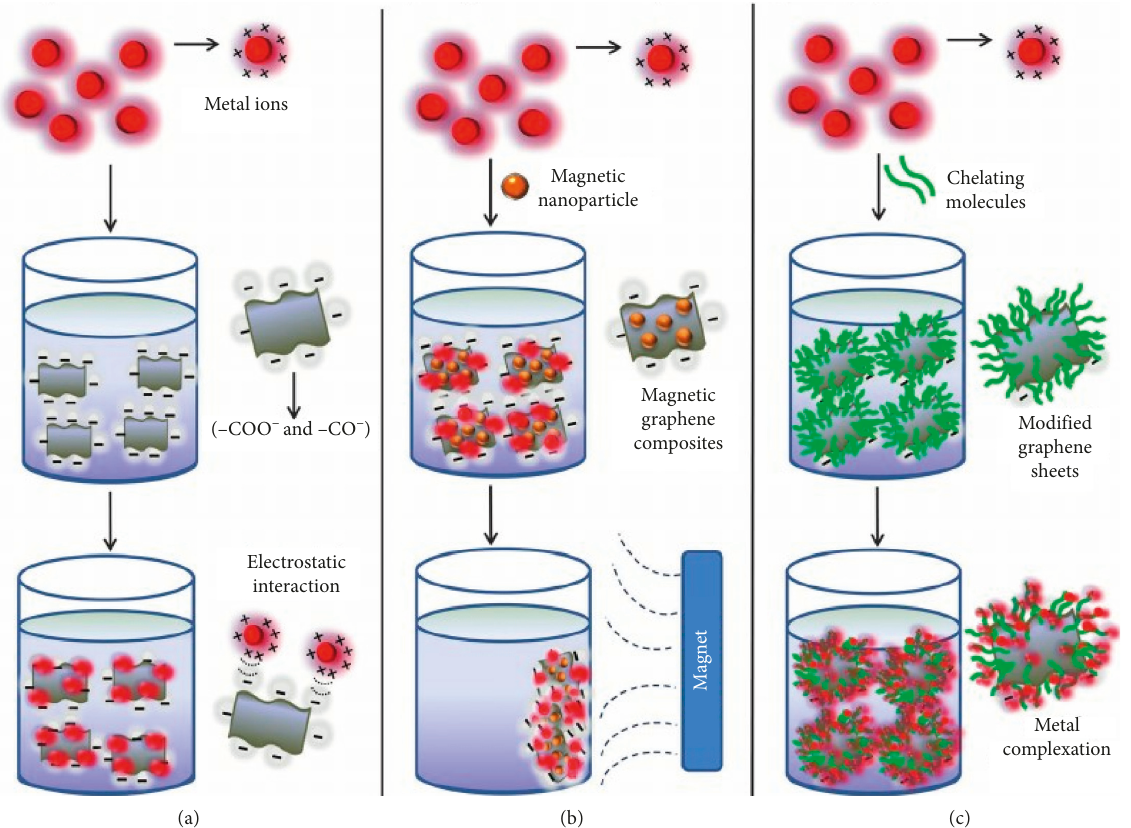
Figure 19: Wastewater treatment: electrical and magnetic approach. (a) Electrostatic interaction. (b) Magnetic nanocomposites. (c) Conjugation with